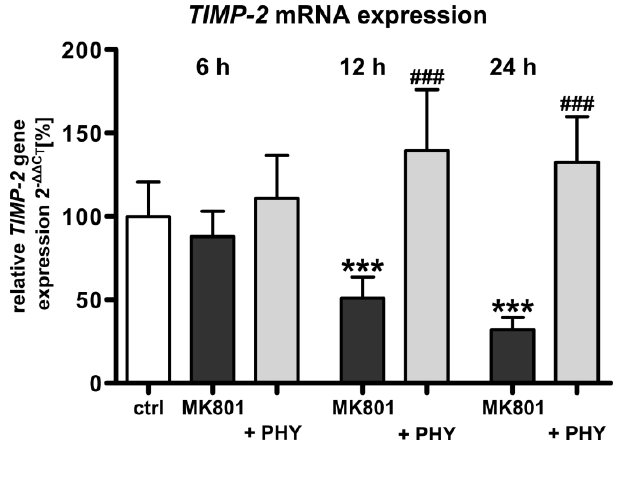
Figure 4. Stabilization of TIMP-2 mRNA expression after AChE inhibition in MK801 treated rat pups. Quantitative analysis of brain TIMP-2 mRNA expression after MK801 treatment (dark grey bars) with or without physostigmine co-application (light grey bars). Data are normalized to levels of vehicle treated pups ((control; white bar, 100%); bars represent mean + SD, n = 6 per group, *** p < 0.001 compared to vehicle treated pups, ### p < 0.001 compared to MK801 treated pups, respectively). ctrl: control; PHY: